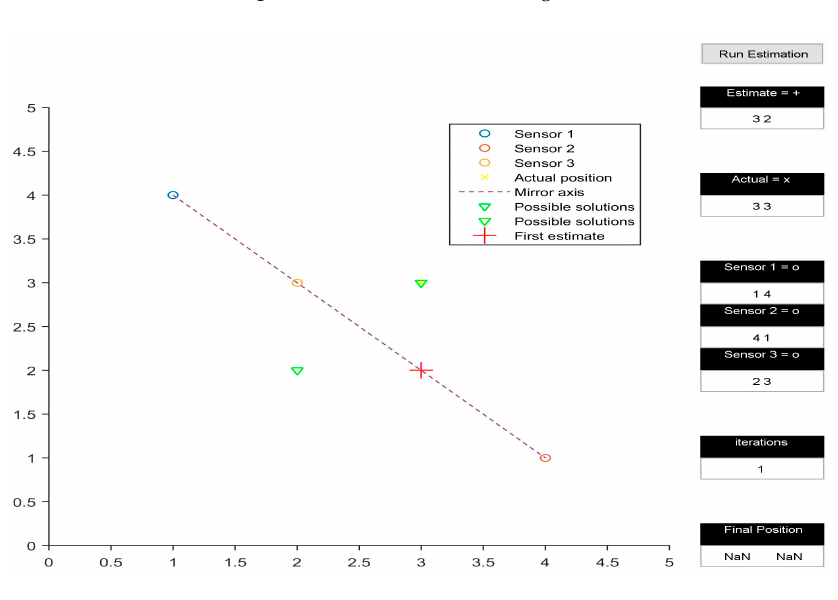
Figure 4. Non-collinear convergence.